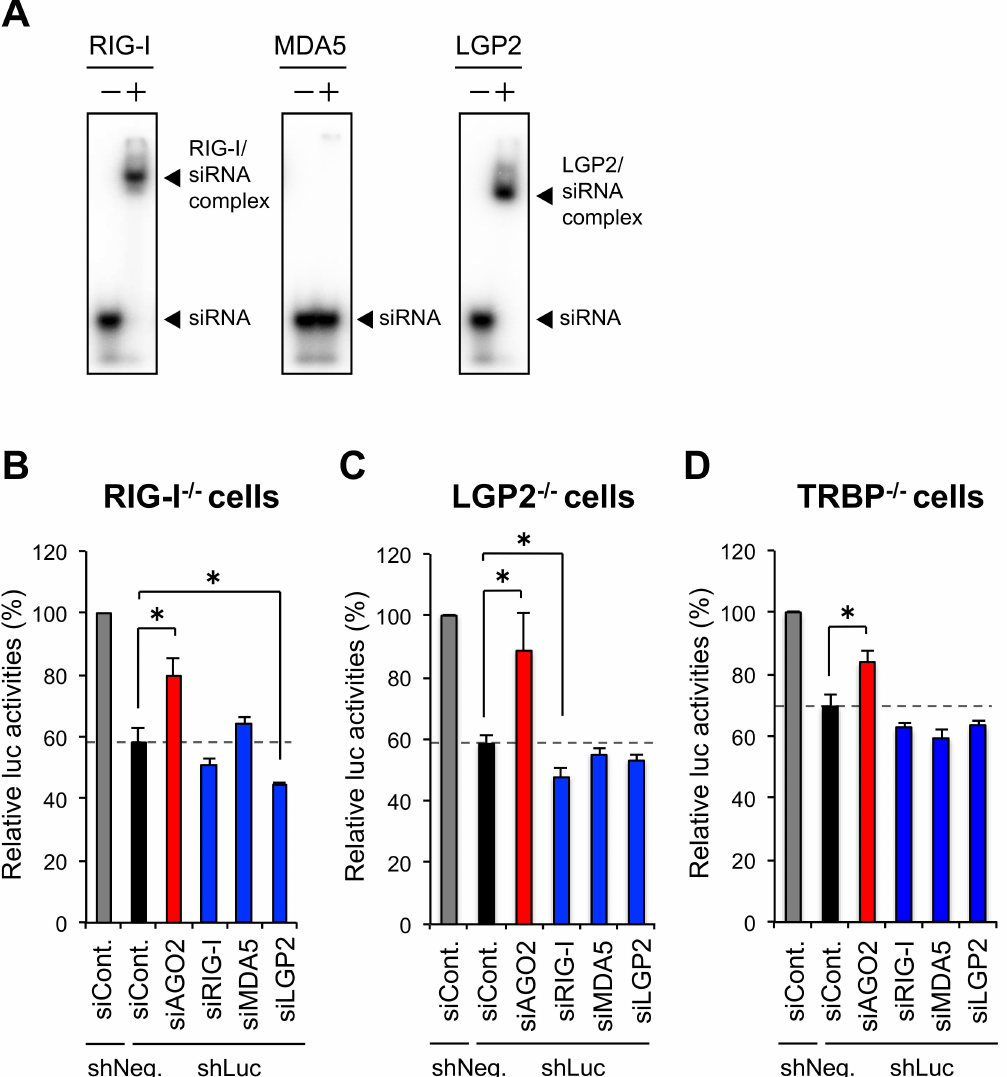
Figure 2. The repression of shRNA-induced RNAi by RIG-I is TAR-RNA binding protein (TRBP)-dependent. ( A ) electrophoresis mobility shift assay (EMSA) of recombinant RLR proteins and siRNA against firefly luciferase (siLuc-36). Each of the purified recombinant RLR proteins and 32 P-labeled siLuc-36 were incubated and electrophoresed on a 9% polyacrylamide gel. ( B ) Luciferase reporter assay in RIG-I − / − HeLa cells with IFN. ( C ) Luciferase reporter assay in LGP2 − / − HeLa cells with IFN. ( D ) Luciferase reporter assay in TRBP − / − HeLa cells with IFN. Representative data from two biological repeats, with mean and standard deviation of technical triplicates. P -values were determined by the Student’s t -test (* p <